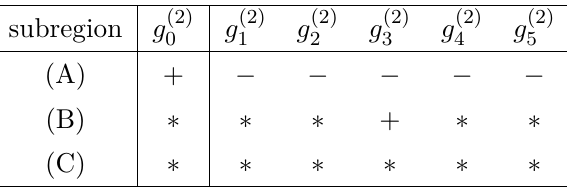
Table 5 . Observed signs of two-loop pure functions in kinematic regions. Correlations among the signs ∗ are shown in more detail in the supplementary